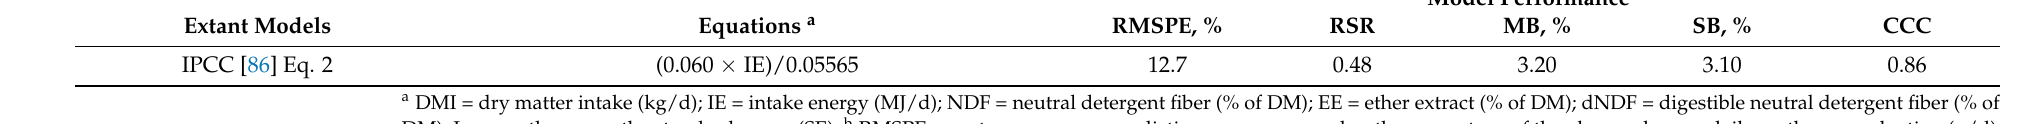
Model Performance b